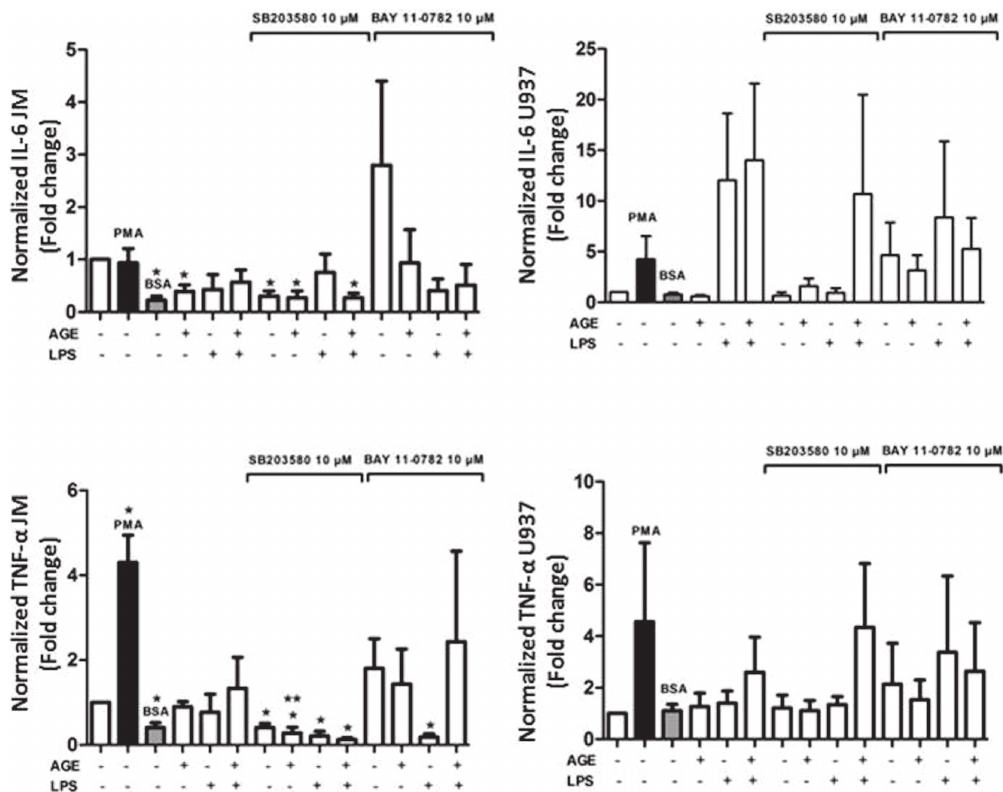
Figure 3- Gene expression (mRNA) of IL-6 and TNF- α evaluated by RT-PCR on human cell lines of T lymphocytes (JM) and monocytes (U937) after stimulation for 6 h with E. coli LPS (100 ng/mL) with or without AGE-BSA (200 ug/mL) in the presence and absence of p38 MAPK inhibitors (SB203580) and NF-kB (Bay 11-7082) inhibitors. The black bar represents the positive control (PMA, 10 nM). Bars indicate mean±standard error of three independent experiments (*) Represents significant difference p<0.05 compared with control group (**) Represents significant difference p<0.05 in relation to the corresponding group without